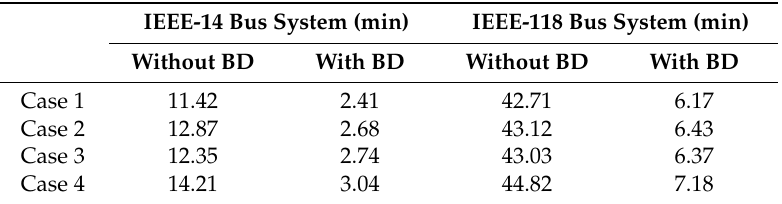
Table 6. Run time for each case with test